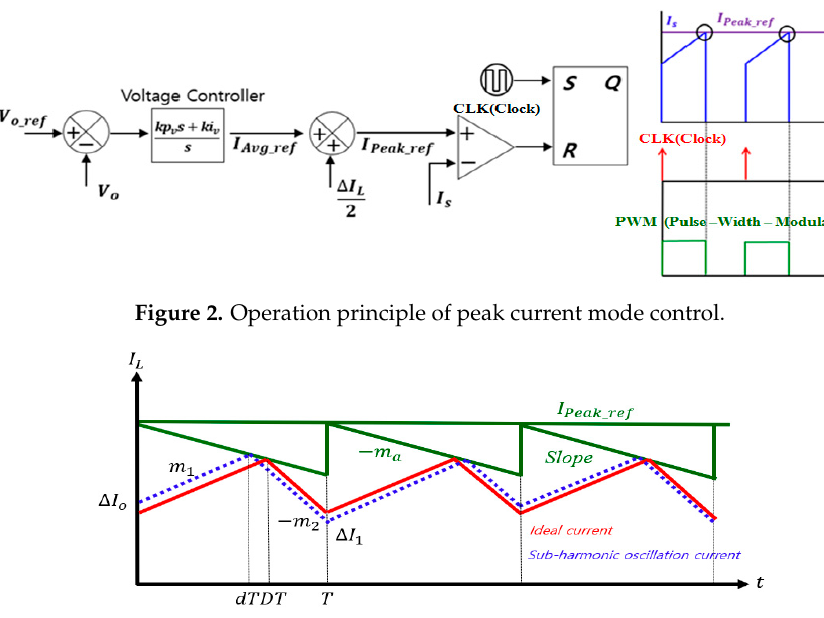
Figure 3. Waveforms with slope compensation at ideal current and sub-harmonic oscillation current.